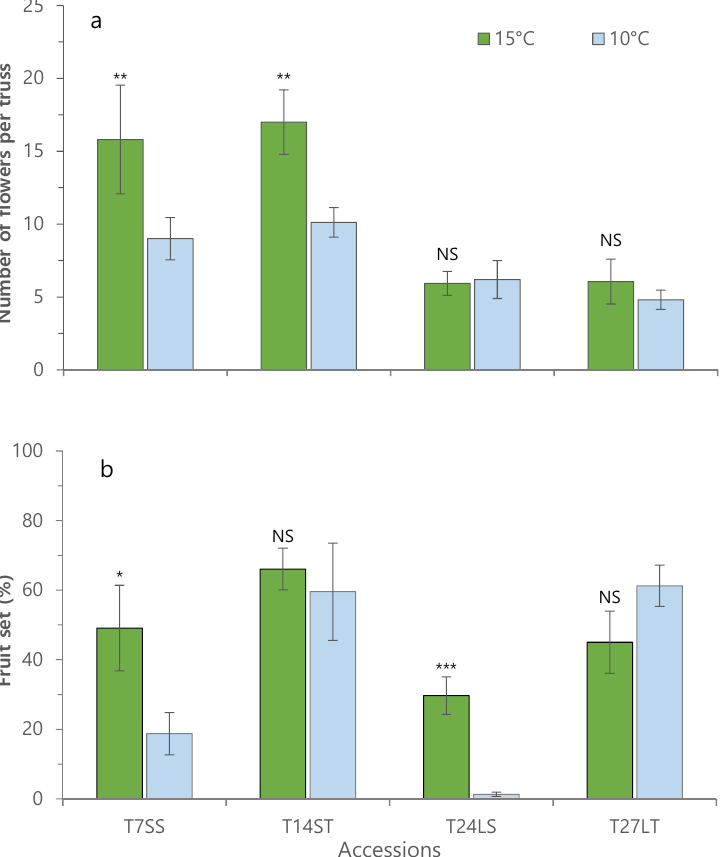
Figure 4. Effects of low night temperature on the number of flowers ( a ) and fruit set ratio ( b ) among tomato accessions. SS: small sensitive, ST: small tolerant, LS: large sensitive and LT: large tolerant. Vertical bars represent means ± SD (n = 4). NS, *, ** and *** indicate not significant and significant at the p ≤ 0.05, p ≤ 0.01 and p ≤ 0.001 levels in t -test, respectively.